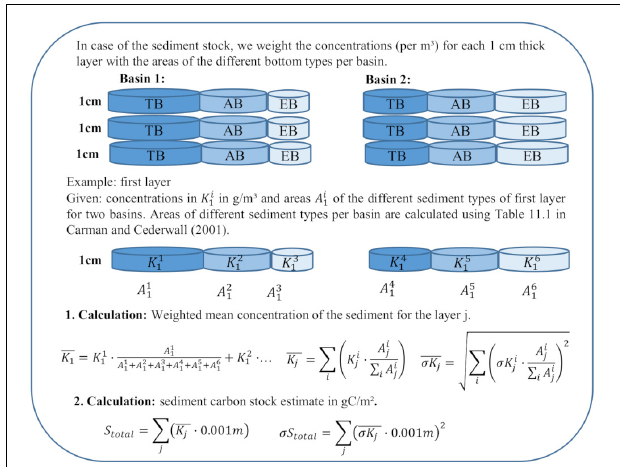
FIGURE 3 | Calculation of the weighted mean concentration per 1 cm-thick sediment layer for the sediment stock. EB, Erosion Bottom; TB, Transport bottom; AB, Accumulation bottom; K i j , concentration for the 1 cm-thick layer j and the basin-specific area of different sediment types A i j ; σ K i j , uncertainty of the concentration for j and A i j ; K j mean weighted concentration for j; σ K j , uncertainty of the weighted mean concentration for j; and S total , total sediment stock in g/m 2